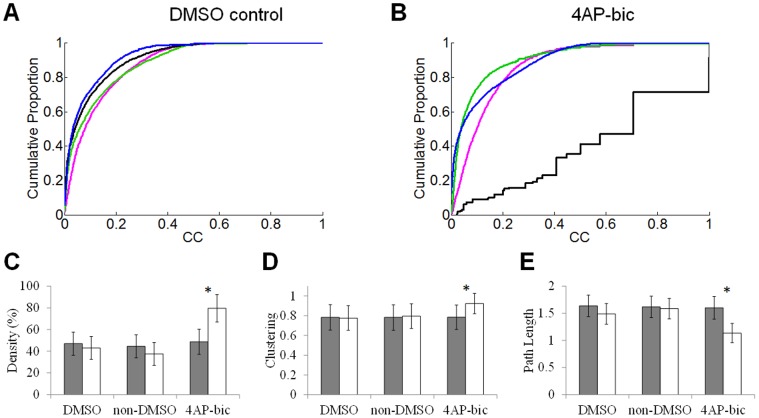
Alterations in functional networks exposed to 4-AP/bic.
A–B: Cumulative distribution of cross-correlations for DMSO controls and 4-AP/bic networks in each recording session. Pink: prior to drug exposure (DIV 14); Green: 24 h after exposure (DIV 16); Black: 4 h washout (DIV 17); Blue: 4 days post washout (DIV 21). With the exception of the recording obtained 4 hours following washout of 4-AP/bic, all networks show a comparable distribution of cross-correlations. C–E: Alterations in network density (C), clustering (D), and path length (E) preceding exposure to 4-AP/bic (gray bars) vs. 4 days post washout (white bars). Vertical bars = SEM. * = p<.01 after Dunn-Bonferroni correction (Wilcoxon rank-sum test).